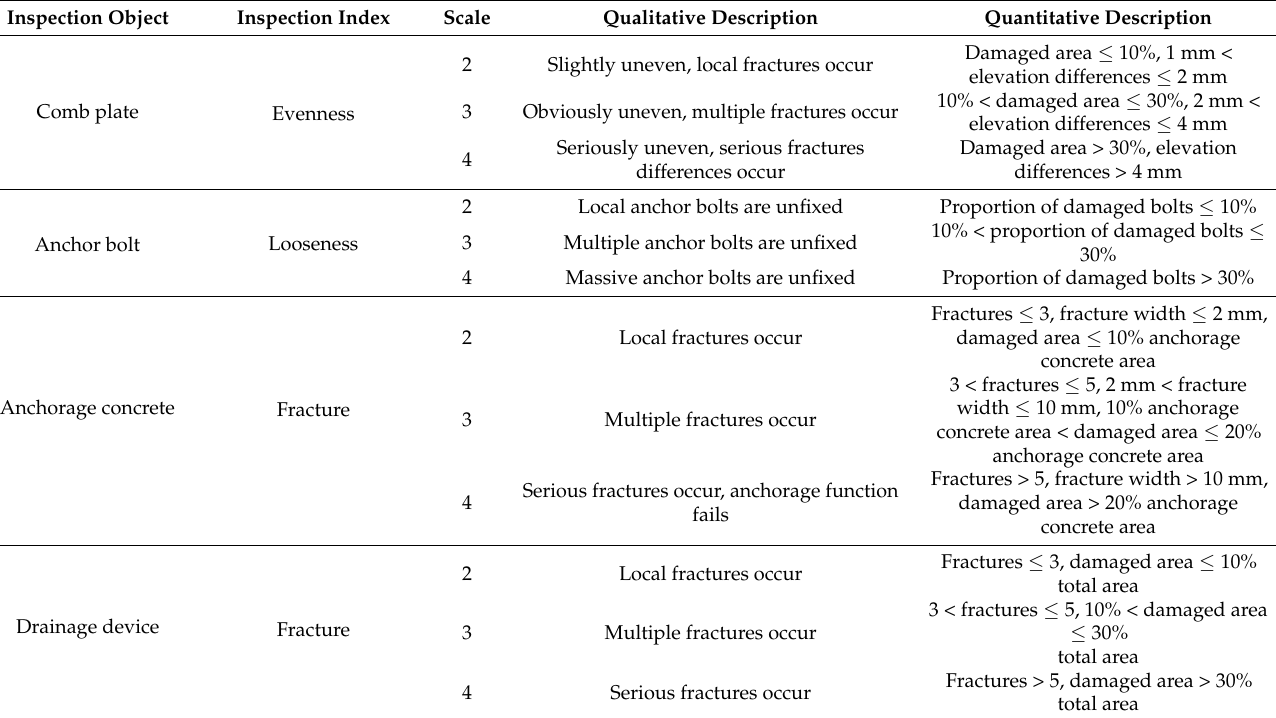
Table 4. Inspection index evaluation of the BECI of SC comb plate type